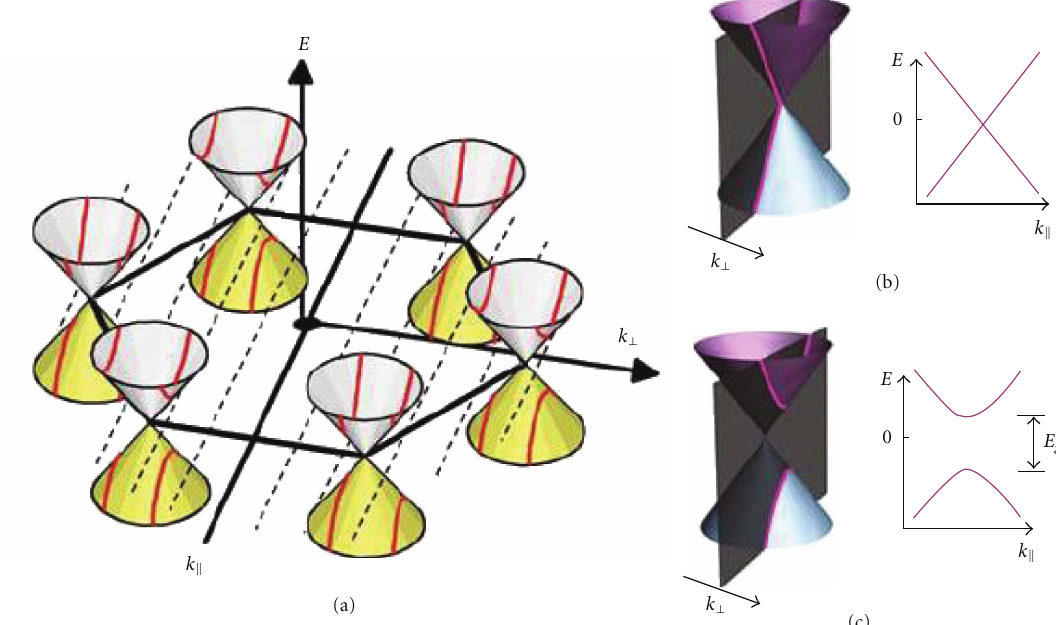
Figure 6: The 1D band structure of an SWCNT is obtained by cross-sections of 2D energy dispersions for (b) a metallic SWCNT and (c) a semiconducting SWCNT [14].